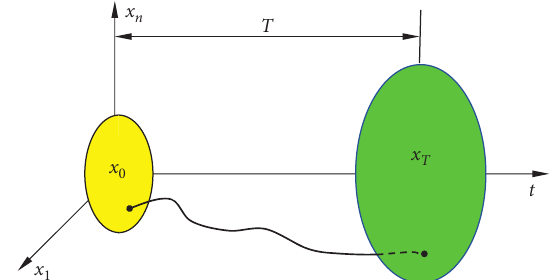
Figure 2: Schematic illustration of finite-time stability in a qual- itative sense.